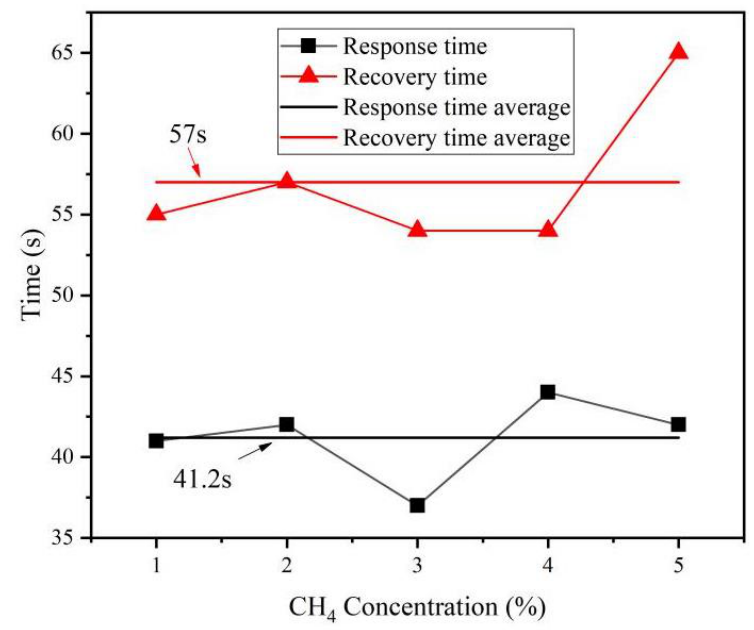
Figure 12. Methane sensor response – recovery characteristic curve.